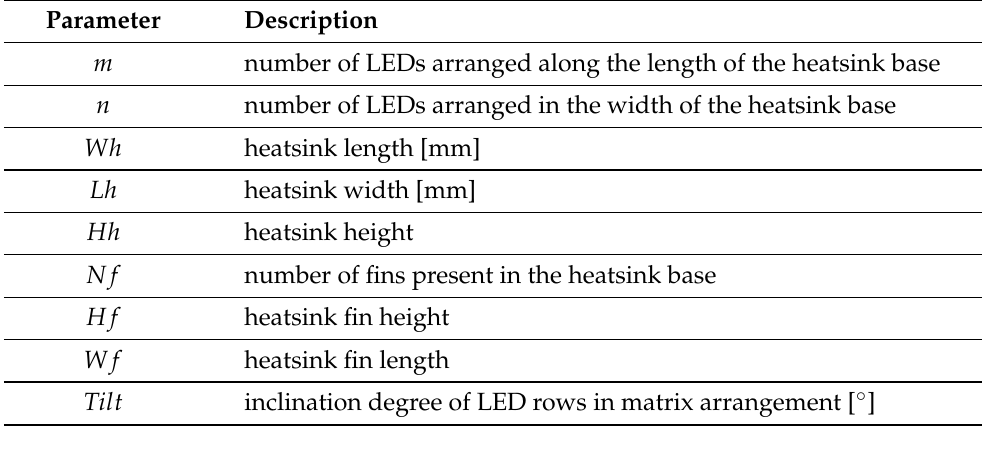
Table 1. Geometric parameters referring to heat dissipation.